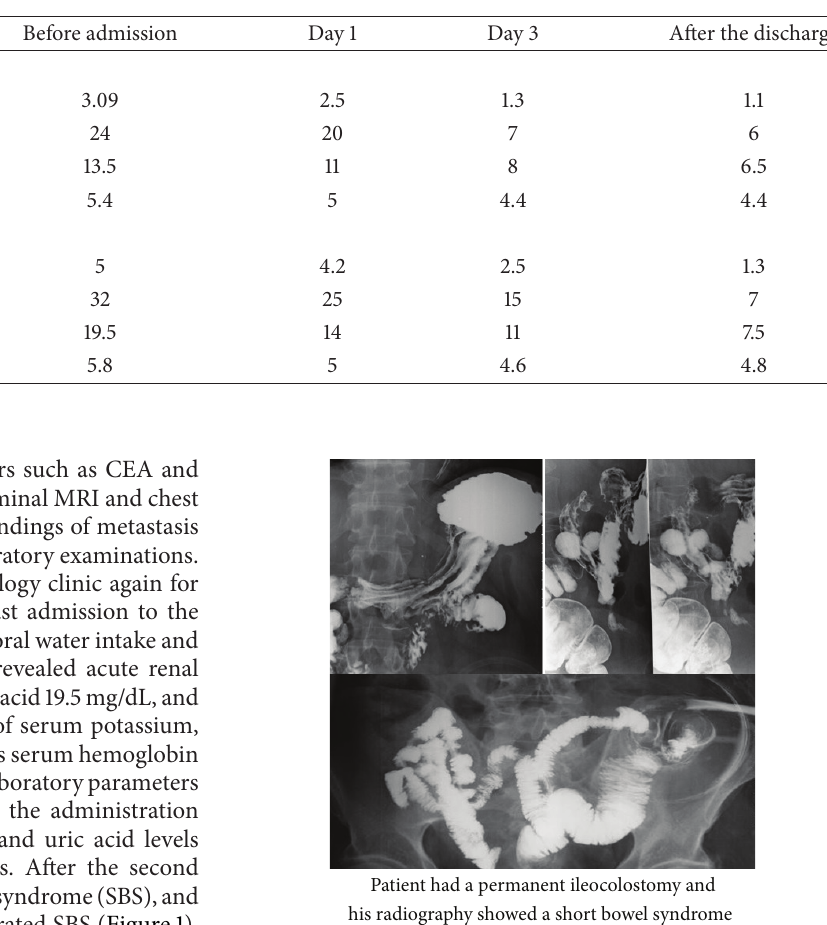
Table 1: Changes of the laboratory parameters during the admission.